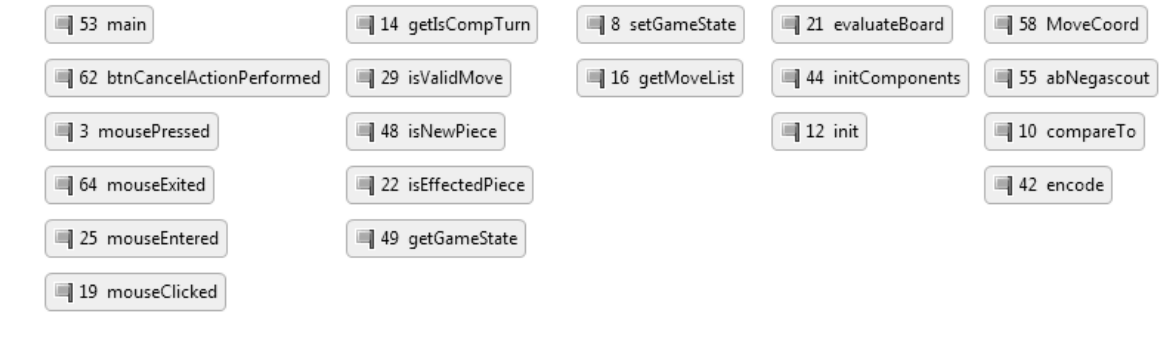
Fig. 7. The isolated functional